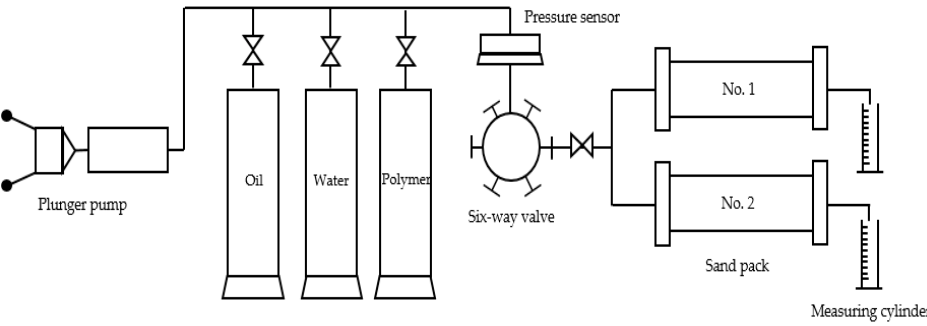
Figure 4. Experiment process diagram. Table 1. Basic parameters of injectivity verification.